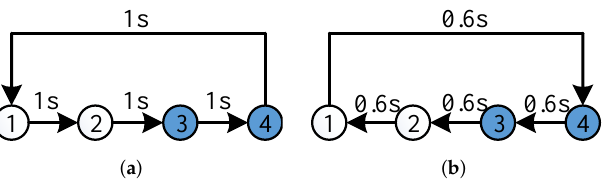
Figure 2. Switching modes of directed topologies r ( k ) .